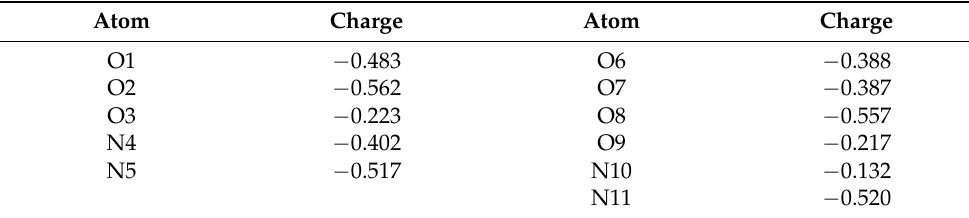
Table 1. Molecular energy, HOMO, and LUMO of acrylamide and acrylamide hexyl hydroxamic acid. Molecule